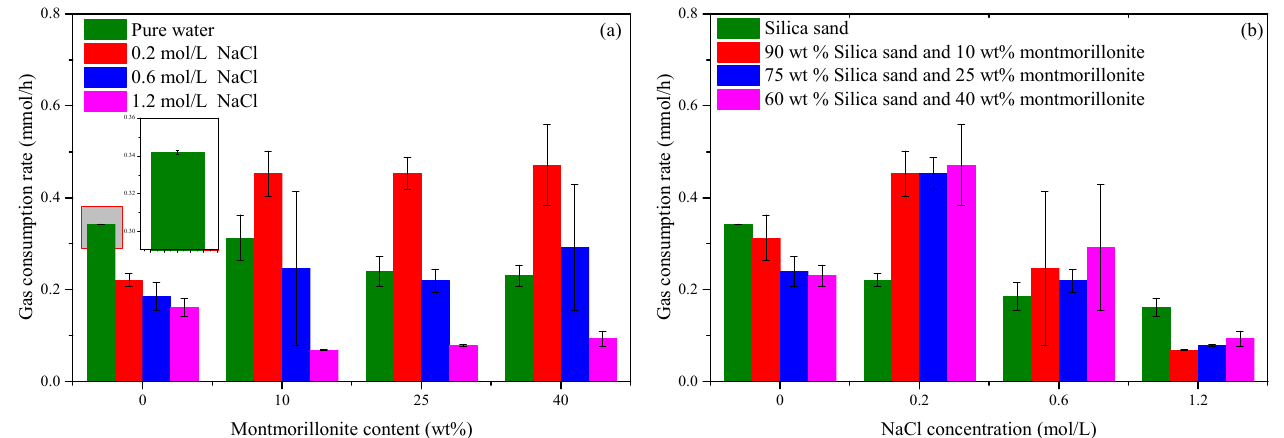
Figure 7. Summary of gas consumption rate. (Error bars represent the experimental deviation). ( a ) Gas consumption rates under different NaCl concentrations. ( b ) Gas consumption rates under different montmorillonite contents.